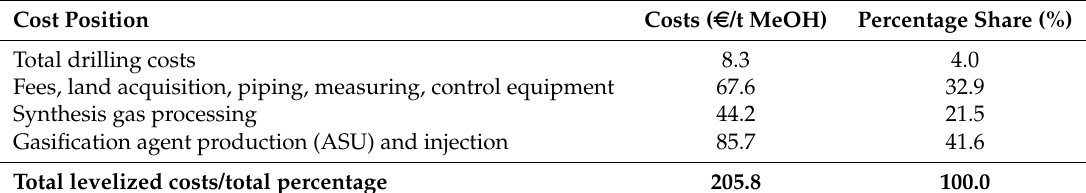
Table 13. Share of individual cost positions on levelized onshore UCG-based methanol production costs for 20 years of